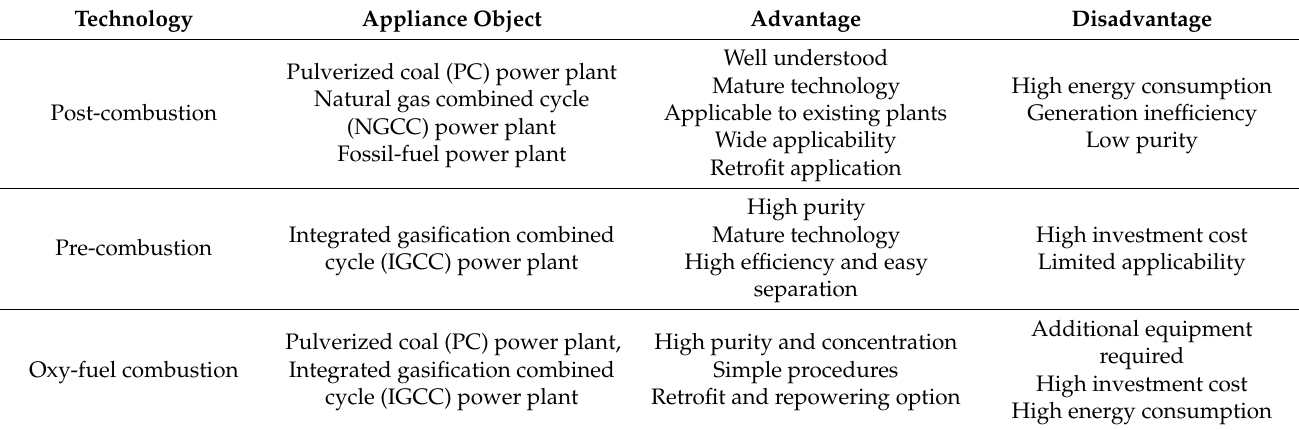
Table 3. Comparison of CO 2 capture technologies